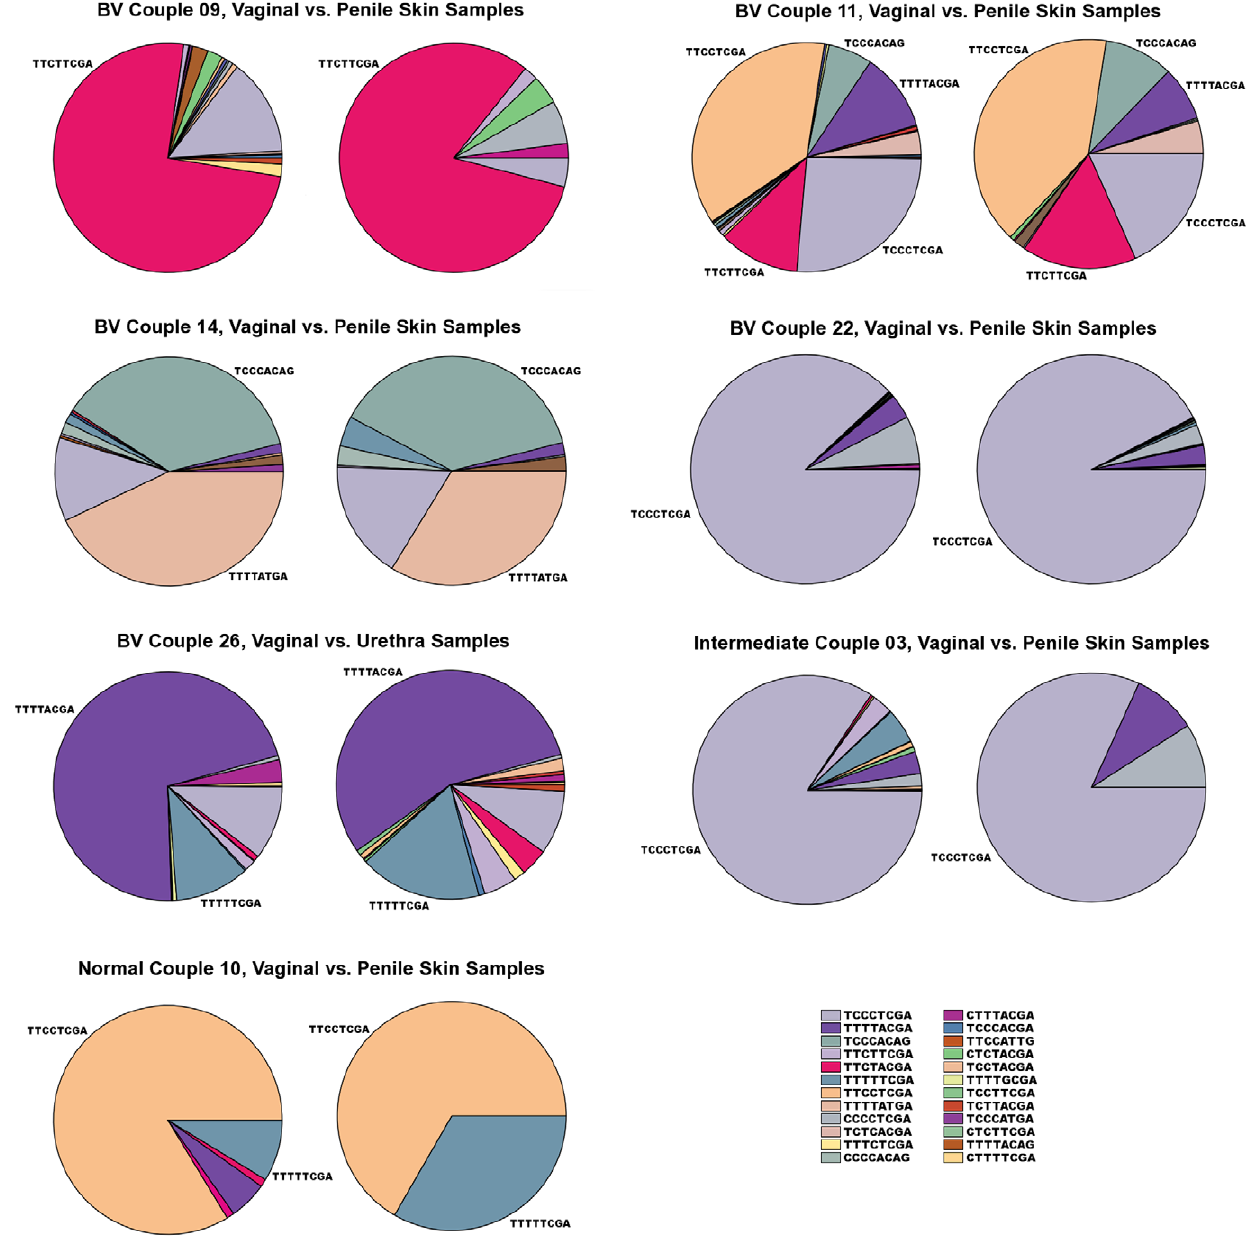
Figure 3. Oligotype profiles in various female patients and their sexual partners. Different colors in the pie charts correspond to different oligotypes. In every set, the pie chart on the left represents the sample collected from the female patient. doi:10.1371/journal.pone.0026732.g003 Figure S1 Phylogenetic distribution of 46 oligotypes. Bars and numbers next to oligotypes indicate how many samples they were present at least once in all samples. (TIFF)